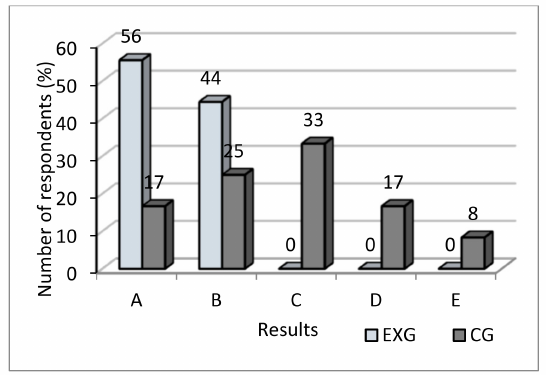
Figure 5. Post-test results in